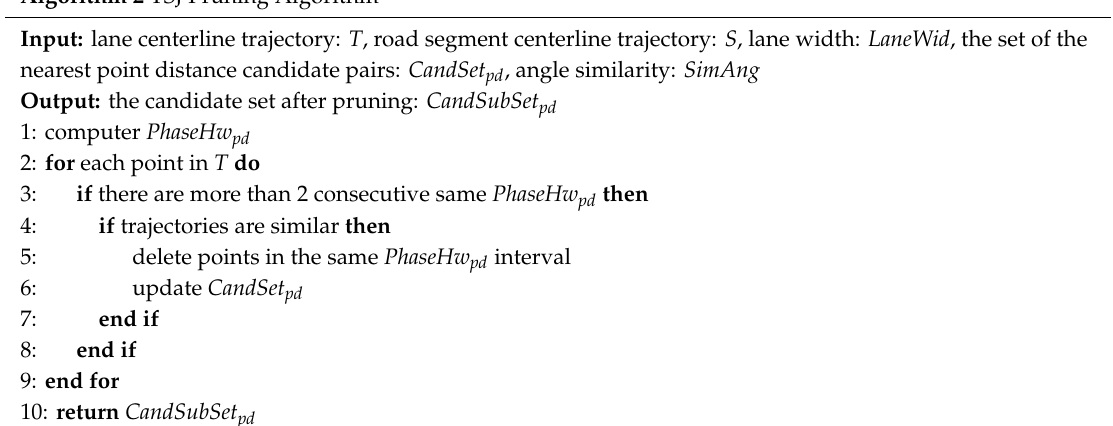
Figure 6. Illustration of Lemma 2. Algorithm 2 TSJ Pruning Algorithm